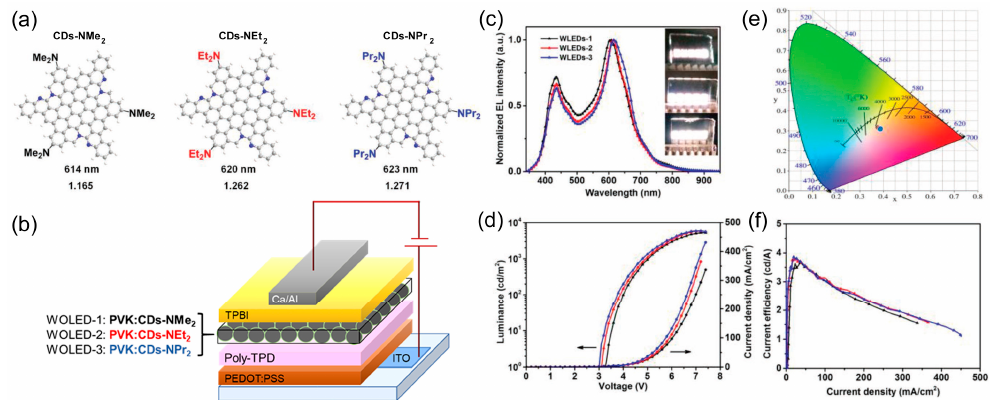
Figure 17. ( a ) CD structures; ( b ) architecture of CD-WLEDs; ( c ) EL spectra of WLEDs 1, 2, and 3 under 7.0 V, (inset, WOLEDs photographs); ( d ) J – L-V characteristics; ( e ) CIE coordinates; and ( f ) η c of WLEDs 1 (black), 2 (red), and 3 (blue): Reproduced with permission from [80], copyright 2019 Wiley-VCH Verlag GmbH & Co.